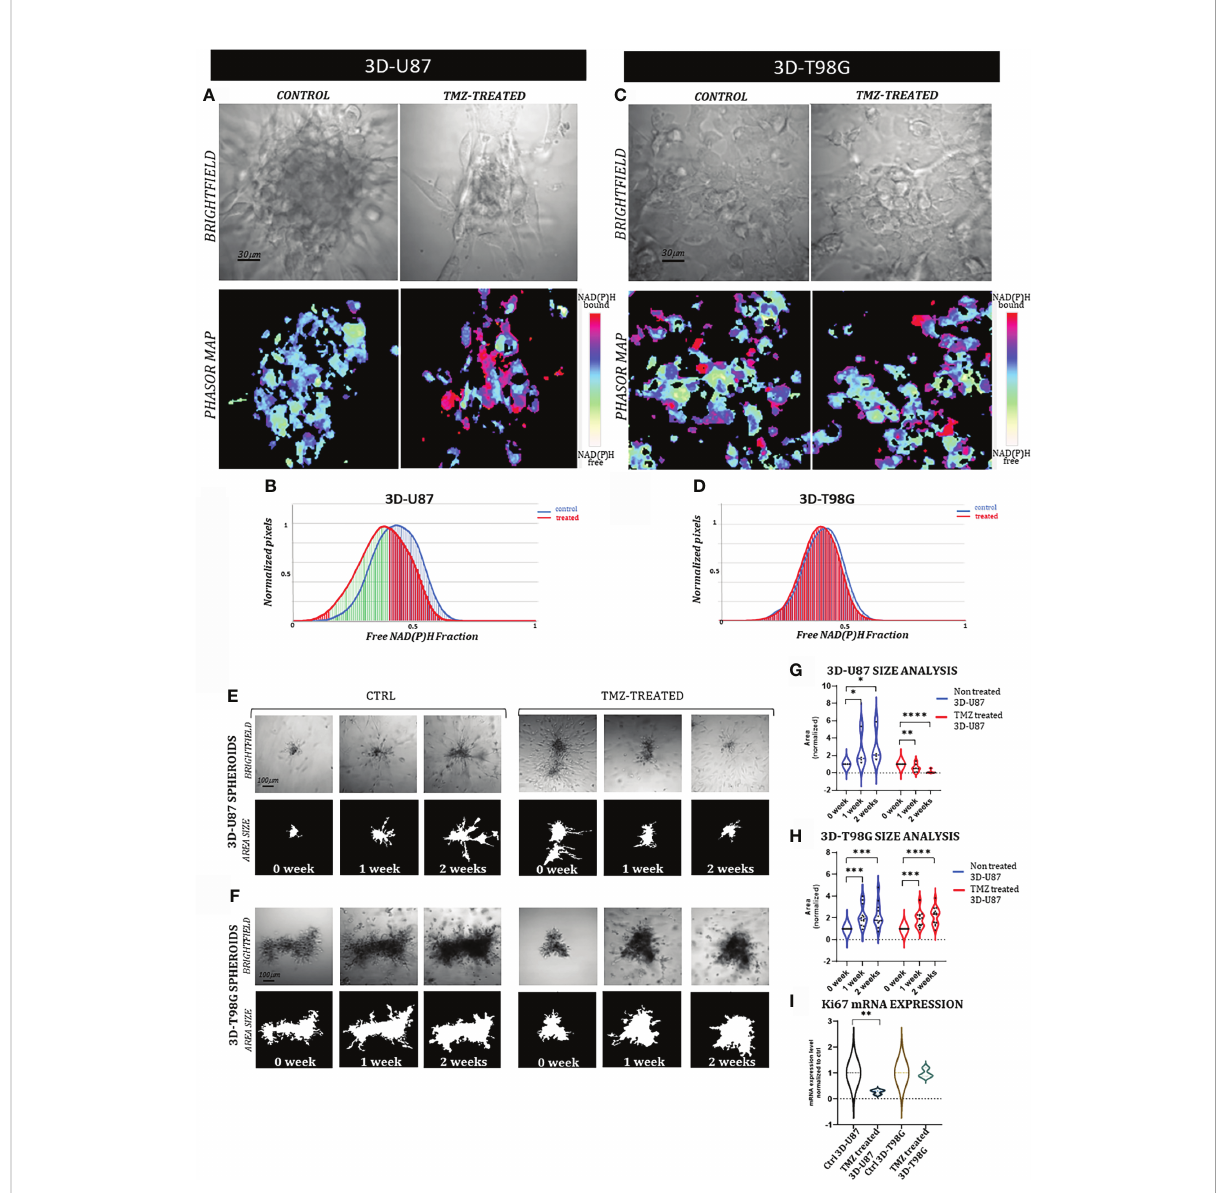
FIGURE 3 FLIM-based metabolic imaging in 3D-U87 and 3D-T98G. (A, C) Representative images of 3D-U87 (A) and 3D-T98G (C) controls and treated cells, subdivided in bright fi eld images of a spheroid and the corresponding phasor map displayed in a false color scale with the coding shown by the bar on the side of the fi gure. Scale bar, 30 m m. (B, D) NAD(P)H fractional mean distribution curves of controls (blue) and treated cells (red) of 3D-U87 (B) and 3D-T98G cells (D) . (B) 3D-U87 cells show a statistically signi fi cant higher fraction of bound-state NAD (P) H in the treated group compared to the ctrl group (55%DR). (D) In 3D-T98G no difference was found between ctrl and treated cells in fractions of NAD(P)H bound molecules (0%DR). (E, F) Representative bright fi eld, and area size images of a 3D-U87 (E) and a 3D-T98G (F) control and TMZ 600 µM treated sample at 0 week, 1 week and 2 weeks. Scale bar, 100 m m. (G) Size analysis of 3D-U87 cells reveals at 1 and 2 weeks a signi fi cant increased area for controls (n=12) (p-value=0.03, Student ’ s t test), and a signi fi cant decreased area for TMZ treated samples (n=12) (p-value=0.003 and p- value<0.00002, respectively, Student ’ s t test). (H) Size analysis of 3D-T98G cells reveals at 1 and 2 weeks a signi fi cant increased area for controls (n=12) (p-value=0.0001, Student ’ s t-test), and a signi fi cant increased area for TMZ treated samples (n=12) (p-value=0.001, p-value<0.00002, respectively, Student ’ s t test). 1 and 2 week areas are normalized to spheroids area at 0 week. (I) Ki67 mRNA expression at 72hrs shows a statistical decrease in rate of proliferation in 3D-U87 TMZ treated compared to controls (p-value=0.002. Student ’ s t test), unlike 3D-T98G. Asterisks indicate level of statistical signi fi